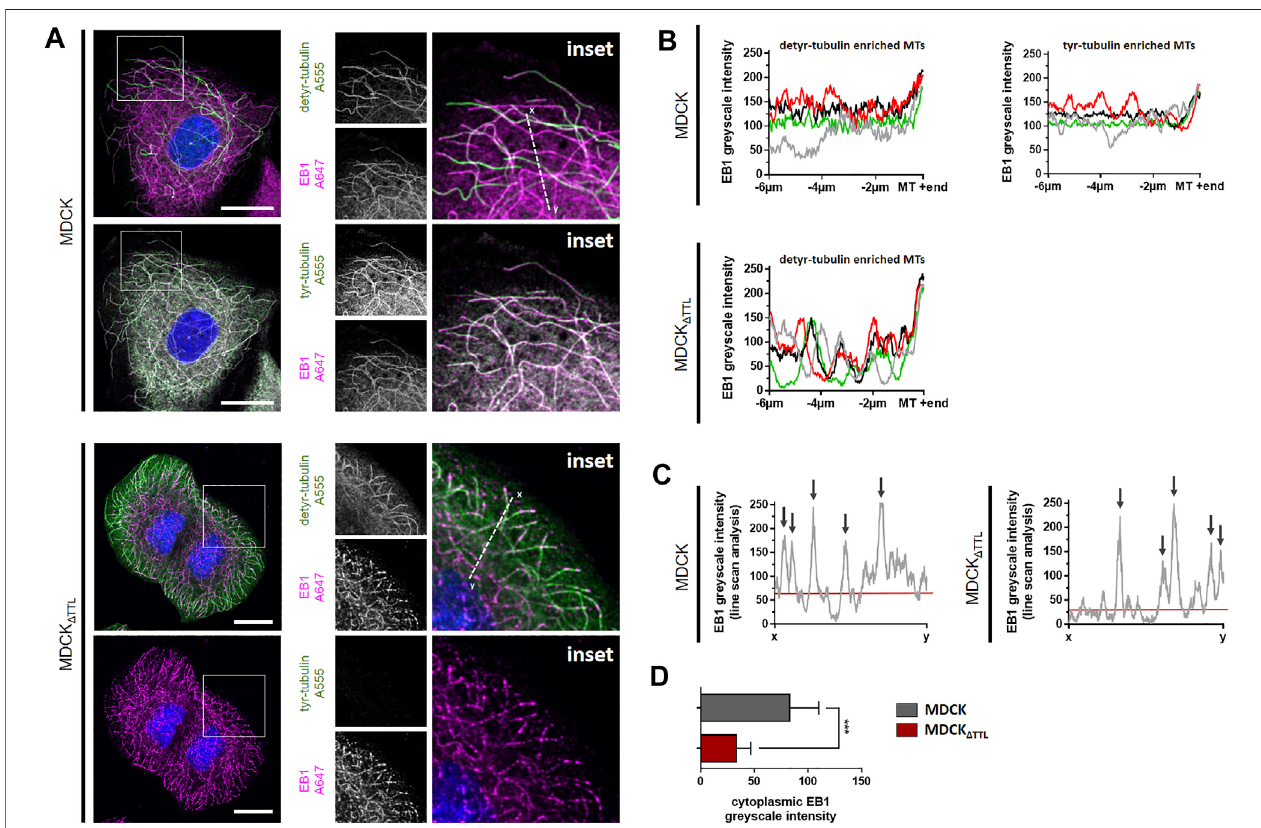
FIGURE 3 | EB1-recruitment along detyr- and tyr-enriched microtubules. (A) Subcon fl uent MDCK and MDCK Δ TTL cells were analyzed by confocal microscopy. Cells were stained for EB1 (Alexa Fluor 647, magenta) and for detyr-tubulin or tyr-tubulin (Alexa Fluor 555, green). Enlarged insets are depicted on the right. Line scans were performed along white dotted lines. Scale bars: 20 µm. (B) EB1 intensities were scanned along four detyr- and tyr-enriched microtubules in MDCK cells. For MDCK Δ TTL detyr-enriched microtubules were scanned. Greyscale intensities (0 – 255) from perinuclear areas to microtubule tips were quanti fi ed by ImageJ. Each color indicates the EB1-distibution pattern along one microtubule. (C) Line scan analysis of EB1 intensity along white dotted lines as depicted in (A) from MDCK and MDCK Δ TTL cells. Greyscale intensities (0 – 255) were calculated by ImageJ. Arrows indicate line scan crossover with microtubule staining. Red lines show the mean cytoplasmic EB1-intensity. Representative results are depicted. (D) Greyscale intensities of EB1 intensities were measured in 20 cytoplasmic regions from MDCK and from MDCK Δ TTL cells. Mean ± s.d., n = 3. Statistical signi fi cance was tested with Student`s unpaired t -test (n.s., not signi fi cant; *** p <